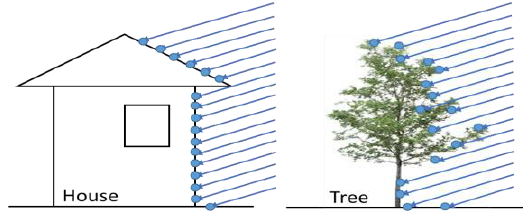
Figure 2. Schematic diagram of scanning result for impenetrable object (Left) and penetrable object (Right)